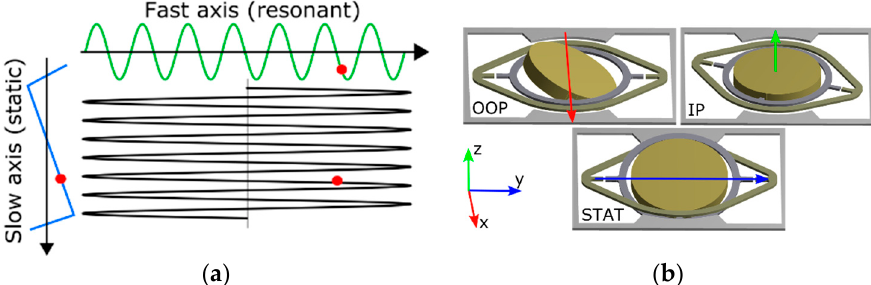
Figure 1. ( a ) Schematic representation of a 2D line scan projection; ( b ) Principle of the proposed actuation concept. The quasistatic (STAT) axis is indirectly driven by gyroscopic effects generated by actuation of the resonant OOP and IP